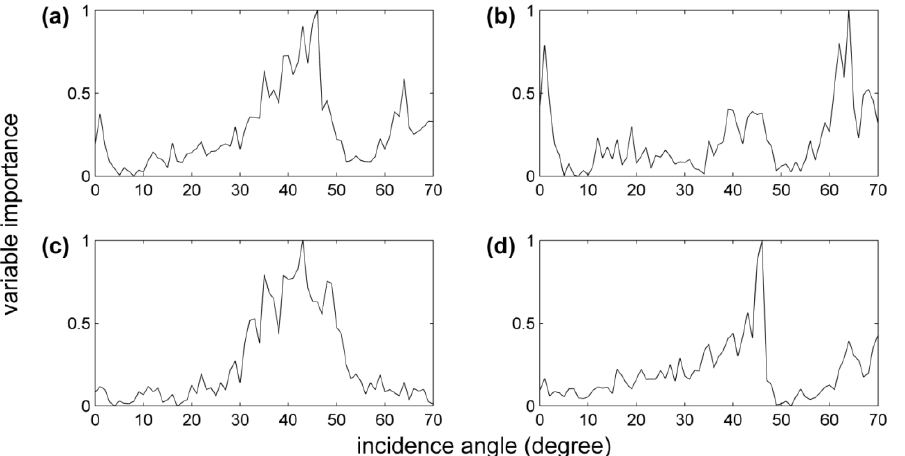
Figure 6. Variable importance (overall and individual class) from Random Forest model scaled from 0 to 1 for substratum classification. The horizontal axis represents incidence angle at one degree interval while the vertical axis represents the value of the variable importance. ( a ) Overall variable importance for substratum classification, ( b ) variable importance for Reef, ( c ) variable importance for Sediment, and ( d ) variable importance for